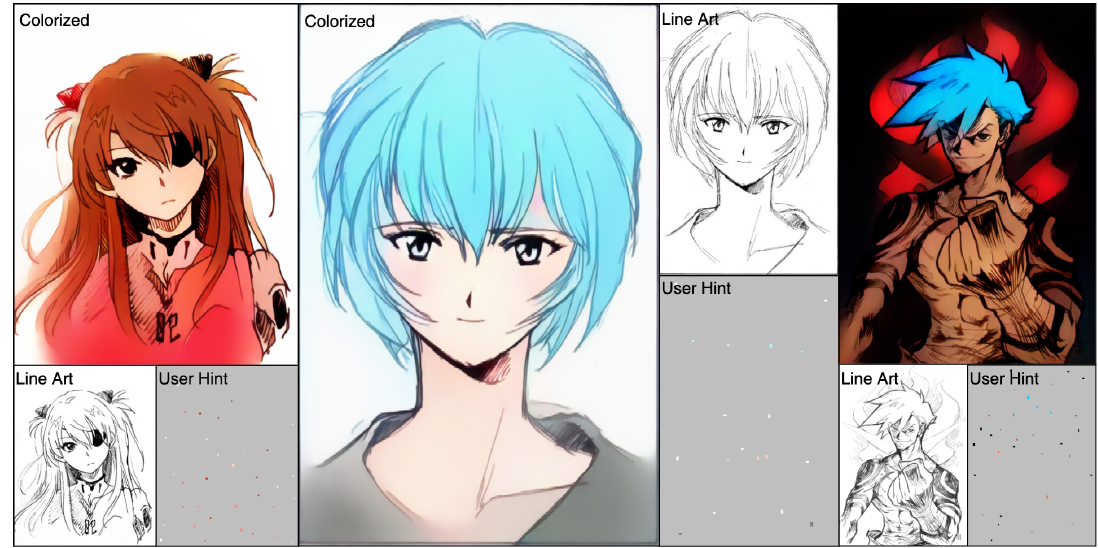
Figure 1. Proposed method’s real word line-art coloring